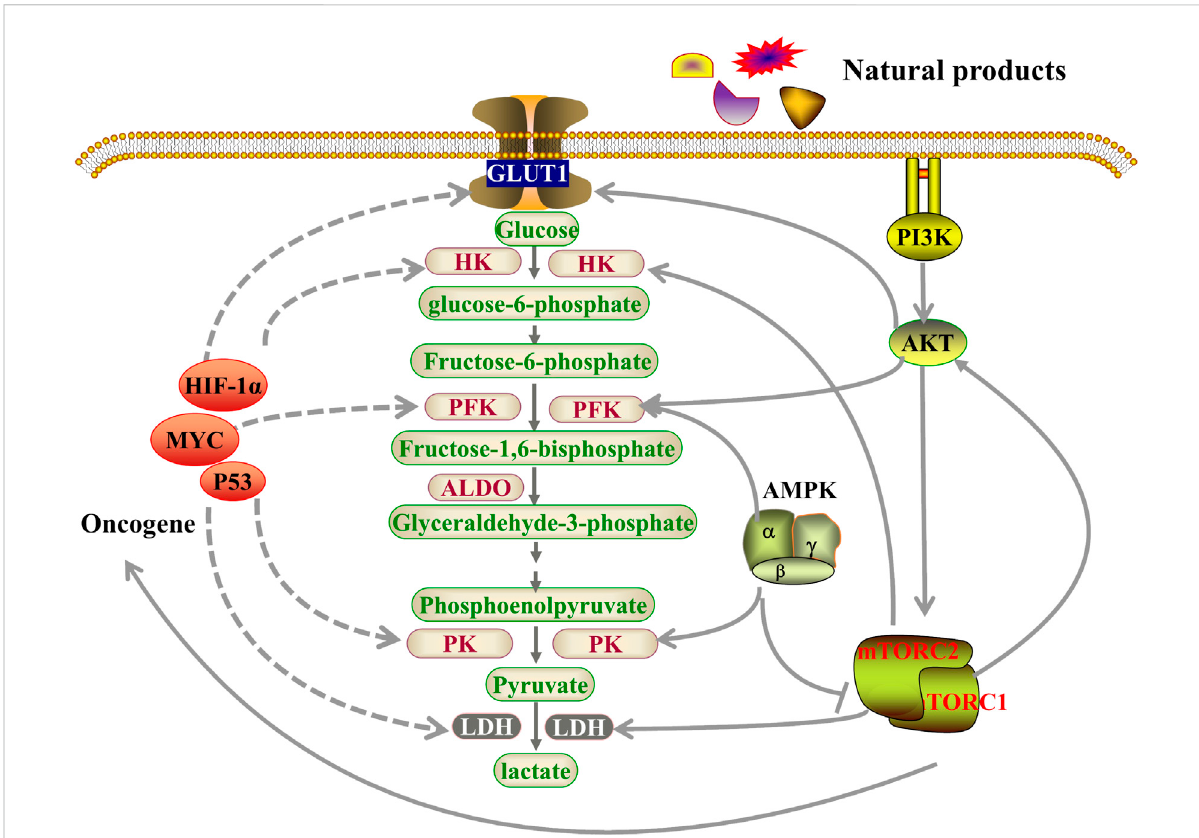
FIGURE 1 Natural products regulated key factors and signaling pathways that are involved in aerobic glycolysis. Natural products may regulate aerobic glycolysisthroughthreepathways.Firstly,naturalproductsaffectglycolysisintumorcellsbydirectlyregulatingglycolyticenzymes;Secondly,natural products may regulate genes related to aerobic glycolysis by regulating oncogenes, including HIF-1 α , MYC and p53, resulting in changes in the metabolic pathways of tumor cells; Thirdly, natural products can act through the PI3K-AKT-mTOR or AMPK pathways to inhibits tumor cell glycolysis. GLUT1, glucose transporter 1; HK, hexokinase; PFK, Phosphofructokinase; ALDO, aldolase, Fructose-bisphosphate; PK, pyruvate kinase; LDH, lactate dehydrogenase;HIF-1 α ,Hypoxia Inducible Factor 1Subunit Alpha; AMPK,AMP-dependent proteinkinase;PI3K, Phosphatidylinositol3- kinase; AKT, protein kinase B; mTOR, mammalian target of